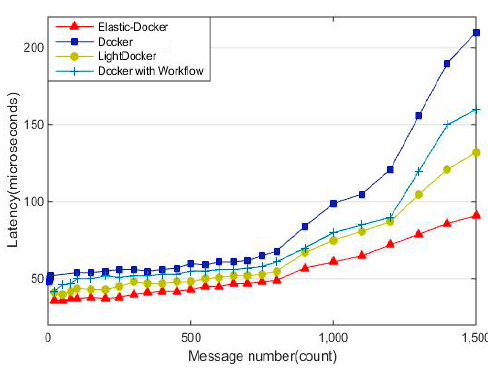
Figure 10. Comparison of service latency.